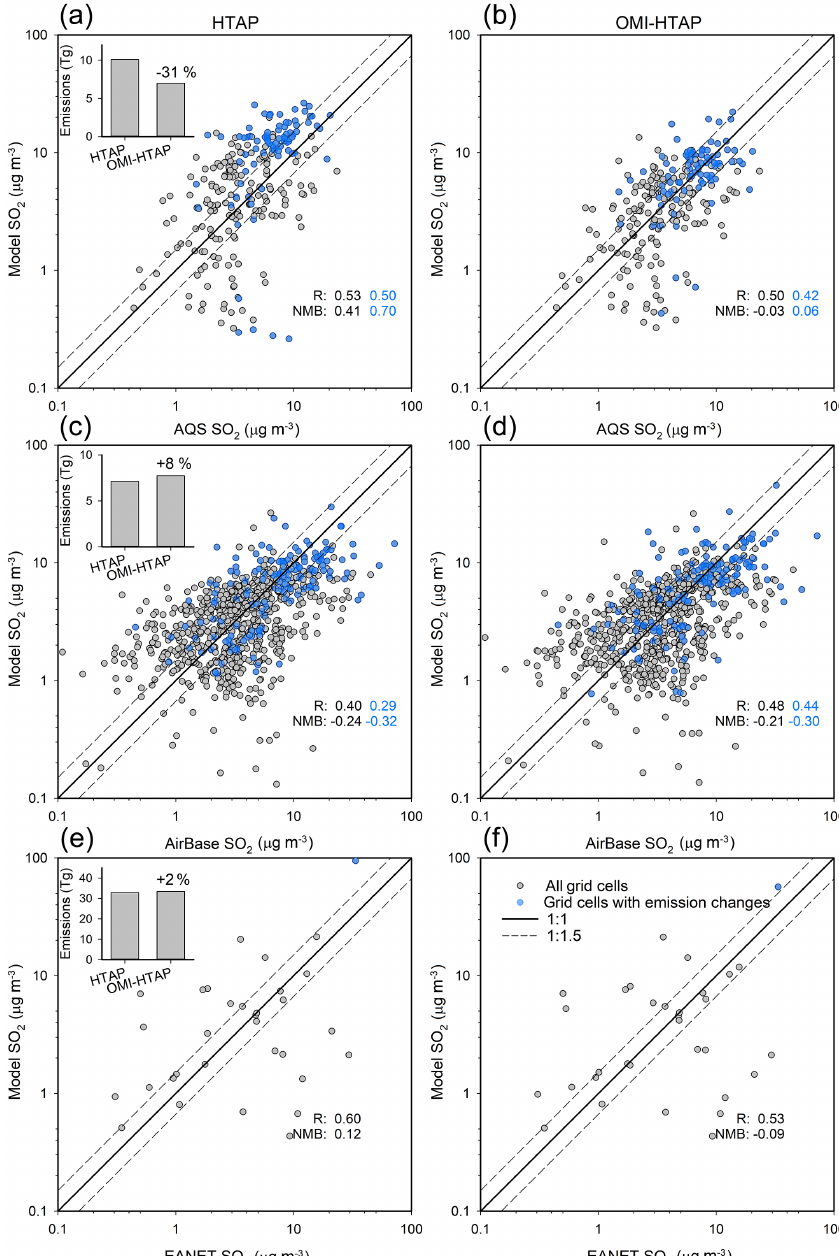
Figure 4. Comparison of 2010 modeled and observed surface SO 2 concentrations. Observations are from the US AQS sites (a, b) , European AirBase sites (c, d) , and East and Southeast Asia EANET sites (e, f) . The annual averaged SO 2 concentrations are calculated for simulations using the HTAP (a) and the OMI-HTAP inventory (b) . The blue dots denote the grid cells with differences in emissions between the HTAP and the OMI-HTAP inventories. The inset plots compare the total SO 2 emissions in those two inventories for the associated regions. The number on the top of the bars indicates the percentage of emission changes when comparing OMI-HTAP to HTAP. The values of correlation coefficient ( R ) and normalized mean bias (NMB) are color coded by black and blue for all dots and blue dots,